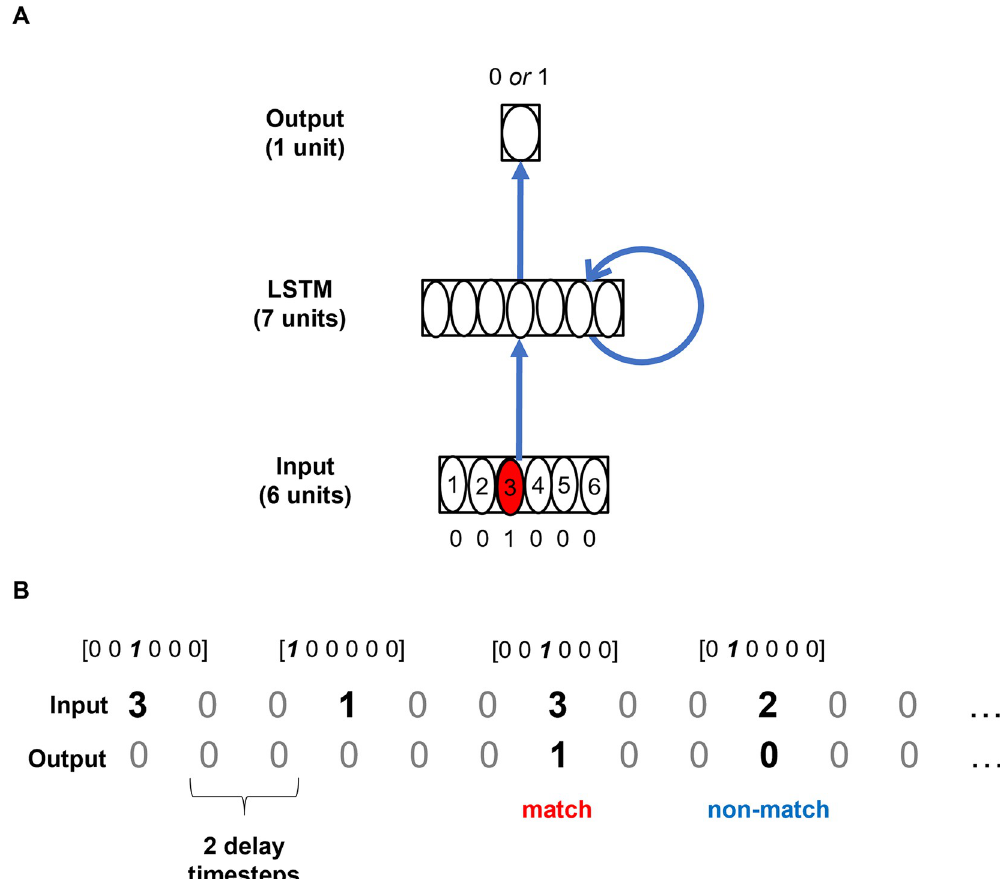
Fig 3. RNN model architecture. Shown is the architecture of the 7-hidden-unit RNNs. (A) One-hot vectors corresponding to each of the 6 stimulus types are fed into the input layer, which projects to an LSTM layer with 7 hidden units. This hidden layer in turn projects to an output unit with a binary target activation (0 = non-match, 1 = match). (B) Example input and target output sequences. Two delay timesteps were installed after each stimulus presentation timestep to emulate the delay period in the 2-back EEG task. 60-hidden-unit RNNs have the same architecture except that they have 60 LSTM hidden units, and two input units that take a vector [cos 2 θ , sin 2 θ ] ( θ denoting the angle of grating orientations used in Wan et al. [13]) instead of a one-hot